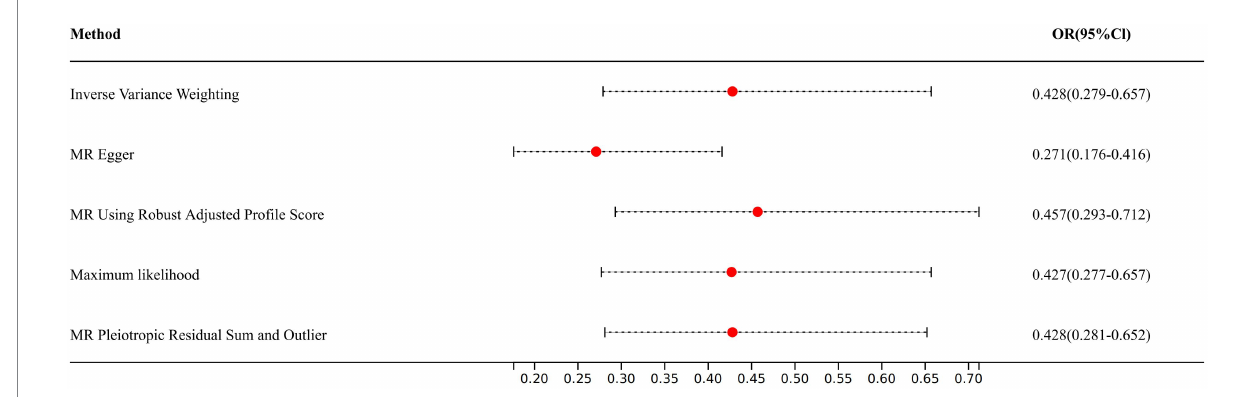
FIGURE 2 Association of Vitamin D with chronic obstructive pulmonary disease in two-sample Mendelian randomization.